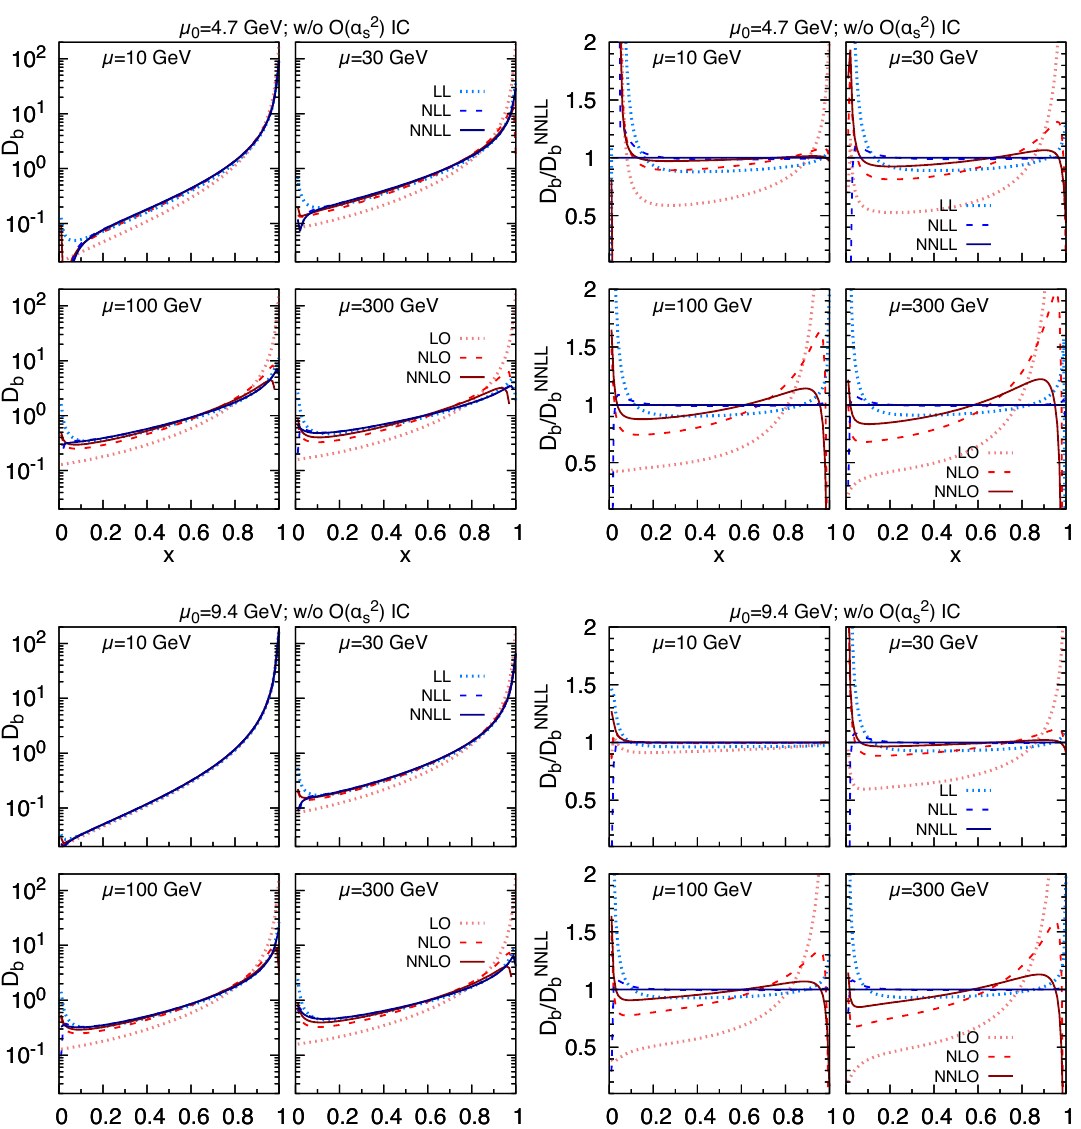
Figure 3 . The x -space bottom-quark fragmentation function, computed at di(cid:11)erent orders for the truncated solution (LO, NLO, NNLO) and resummed solutions (LL, NLL, NNLL). Four values of the factorisation scale (cid:22) are considered in each panel: (cid:22) = 10 ; 30 ; 100 ; 300 GeV. In the top (bottom) panels, the initial scale is set to (cid:22) 0 = m = 4 : 7 GeV ( (cid:22) 0 = 9 : 4 GeV). The right panels show the ratio over the NNLL-accurate